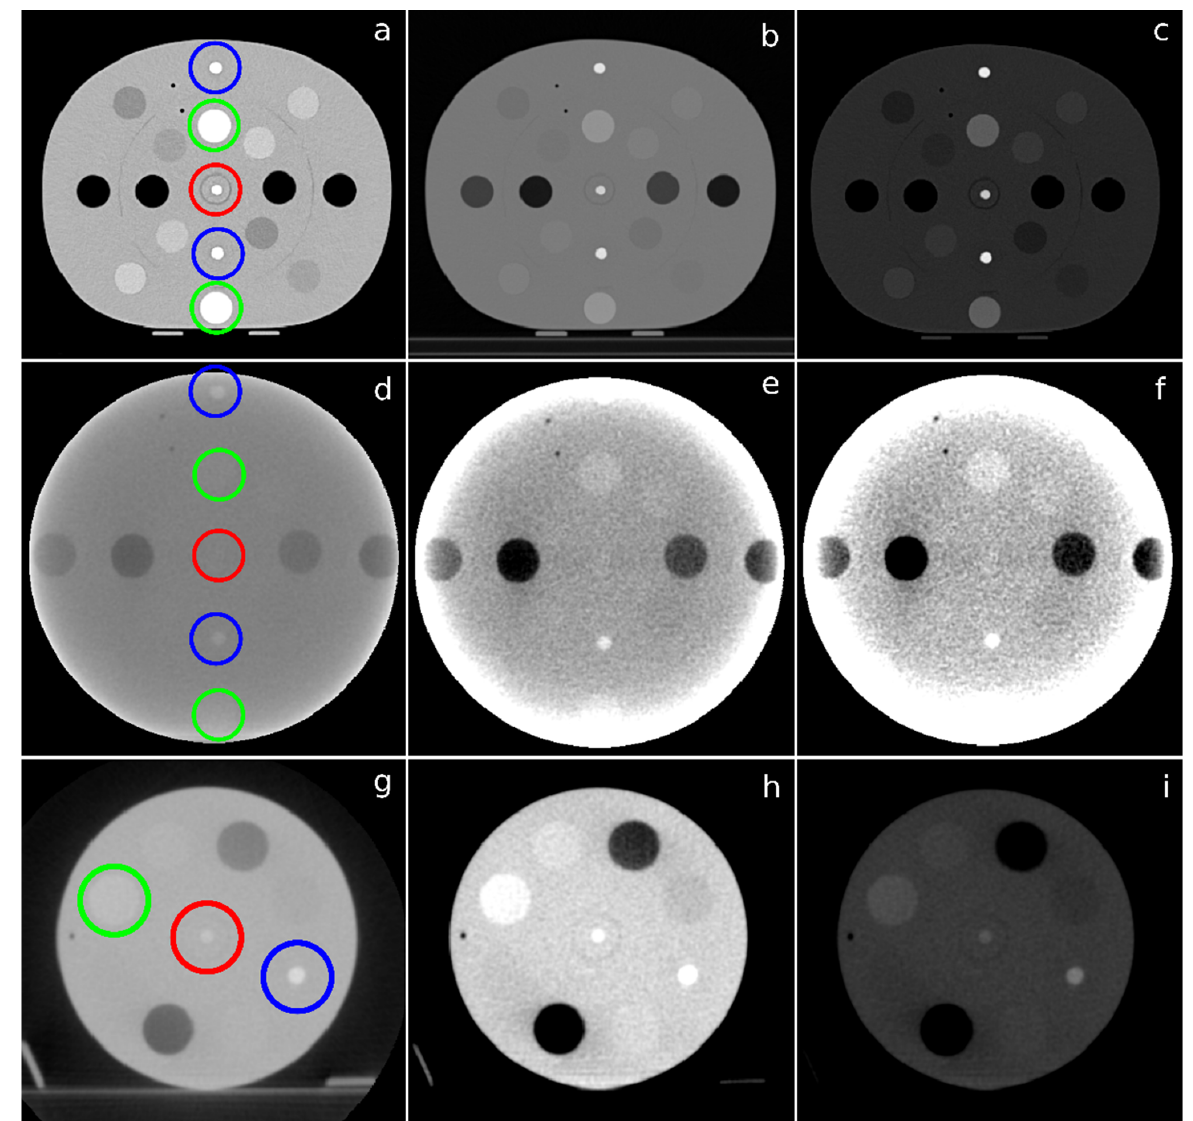
Figure 3. ( a ) axial CT slice of the phantom with body configuration and 22.3 mg Au·mL − 1 solution concentration of AuNP in the center slot, and the same slice after applying a soft tissue; ( b ) and a bone; ( c ) radiological window. The X-ray spectra energy was 120 keV. ( d ) MV-CBCT image of the phantom with body configuration and 22.3 mg Au·mL − 1 solution concentration of AuNP in the center slot, and the same image after applying a soft tissue; ( e ) and a bone; ( f ) radiological window; ( g ) MV-CBCT image of the phantom with head and neck configuration and 22.3 mg Au·mL − 1 solution concentration of AuNP in the center slot, and the same image after applying a soft tissue; ( h ) and a bone; and ( i ) radiological window. Red, green, and blue circles indicate the location of the Falcon tube with AuNP, trabecular bone insert, and dense bone insert, respectively.